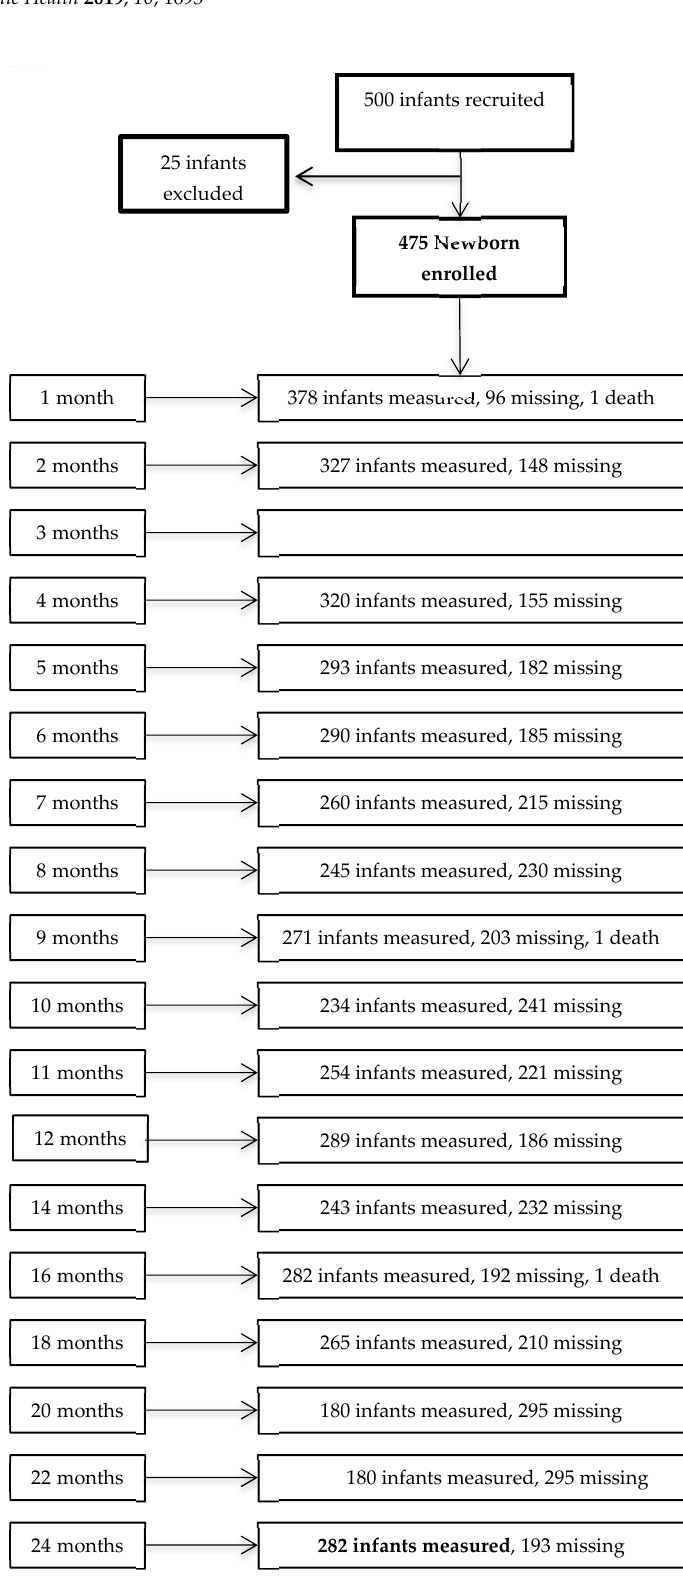
Figure 1. Flow-chart showing the number of infants measured and missing at each point of assessment during the study period.